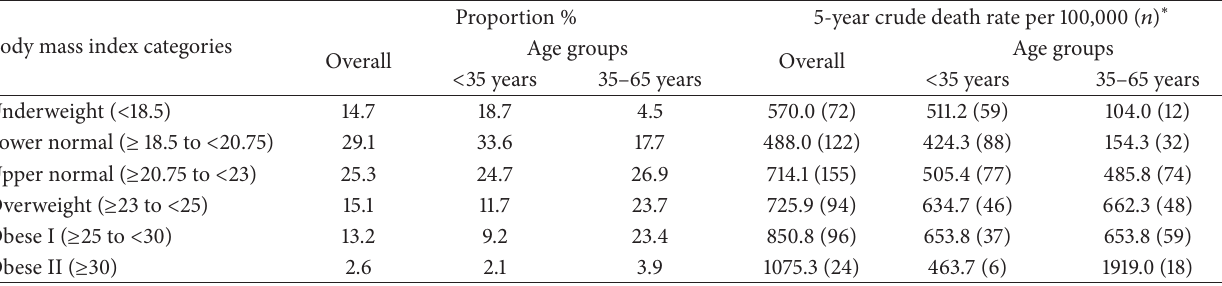
Table 1: Body mass index and all-cause mortality, Thai Cohort Study